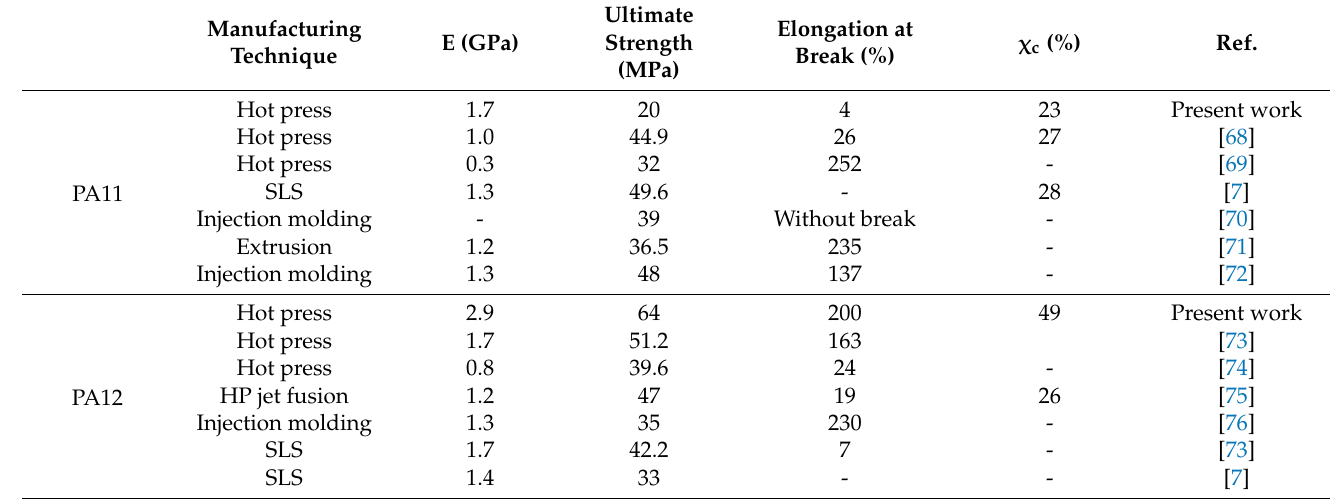
Table 2. Comparison of tensile properties between the present study and previous